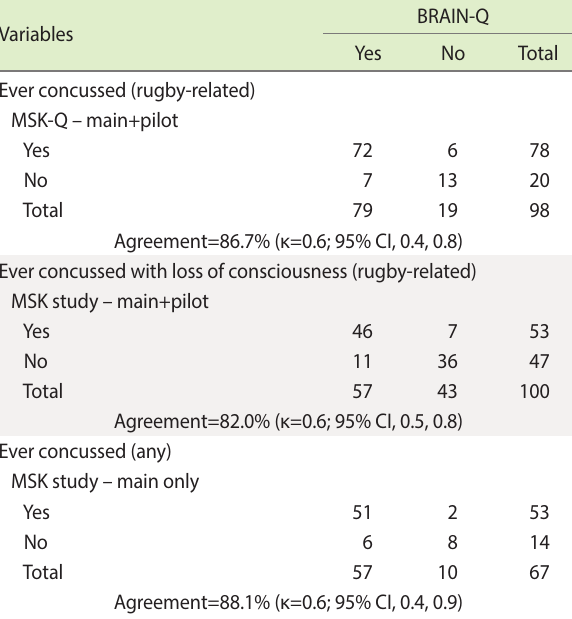
Table 3. Cross-tabulation of the dichotomous rugby-related con- cussion 1